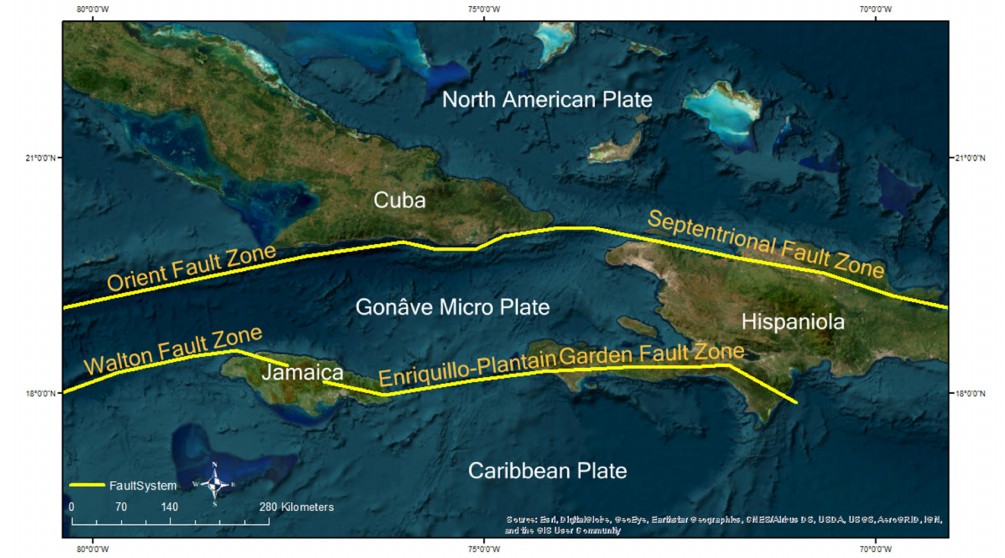
Figure 2. Jamaica’s complex geomorphological position in the Caribbean. Because of its Caribbean placement, Jamaica is subject to the overall regional bimodal seasonal rainfall pattern of early (April–July) and late (August–November) and a general mid-summer drought [15]. The northeastern area of Jamaica receives the highest rainfall yearly average of more than 400 mm, with the Blue Mountains averaging more than 625 mm per year. Jamaica is also significantly exposed to tropical storms, with at least 11 named storms making landfall between 1988 and 2012 [15–17]. In both cases, this rainfall surplus usually causes floods, flash floods, and landslides throughout the island [17]. Figure 3 below shows the recurrence of floods and landslides affecting the island from 1973 to 2017 as reported in the EM-DAT global natural disasters database [18] and NASA’s global landslide catalog [19]. EM-DAT does not provide more recent information. These natural hazards heavily affect the Jamaican population, estimated at 2.8 million people today, and result in significant GDP losses